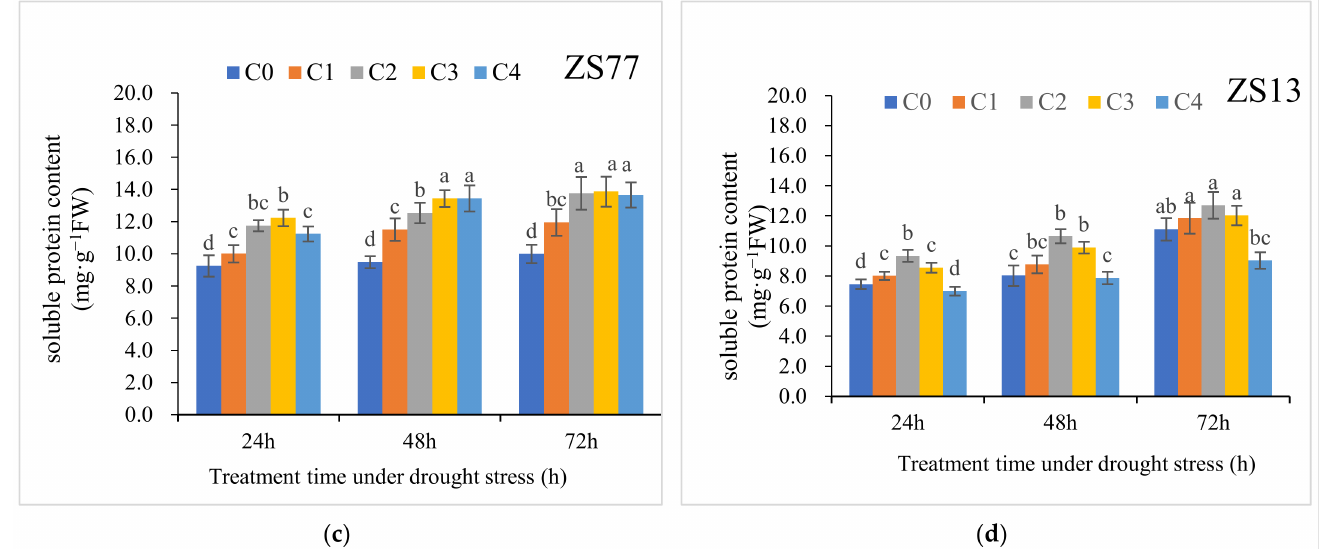
Figure 7. Effect of different concentrations of exogenous SA solution 0 (C0), 1.00 (C1), 2.00 (C2), 4.00 (C3), and 8.00 mg · L − 1 (C4) on soluble sugar ( a , b ) and protein ( c , d ) in sweet-potato leaves under drought stress. Bars with different letters indicate significant differences among treatments at 0.05 level (Duncan).